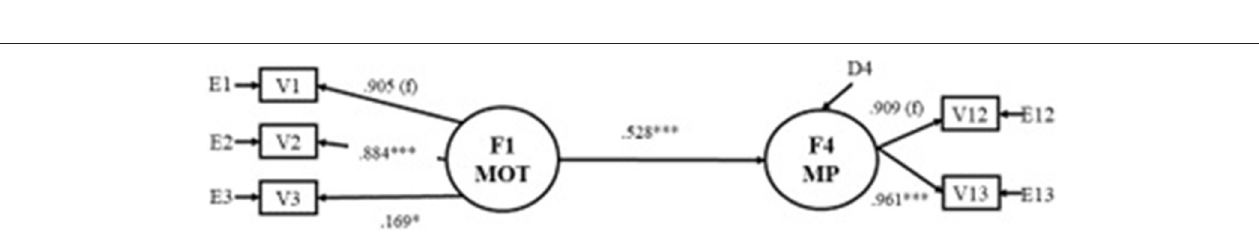
FIGURE 2 | Results of the effects (in standardized scores) of the initial model proposed in Figure 1 . F1 MOT, Motivation; F2 EF, Executive Functioning; F3 ENS, Early Numeracy Skills; F4 MP, Mathematical Performance; V1, Competence-motivation; V2, Attention-persistence; V3, Positive internality; V4, Inhibition-Sun/Moon Stroop; V5, Inhibition-Tapping Task; V6, Working memory-Digit Span Backward; V7, Working memory-Counting Task; V8, Procedural counting; V9, Conceptual counting; V10, Logical operations; V11, Symbolic comparison; V12, Informal skills; V13, Formal skills. f , fixed effect; * p < 0.05; ** p < 0.01; *** p < 0.001; n.s., non-significant.